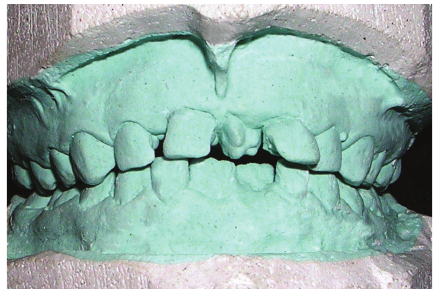
Figure 1: Model showing multilobulated mesiodens between max- illary primary central incisors.